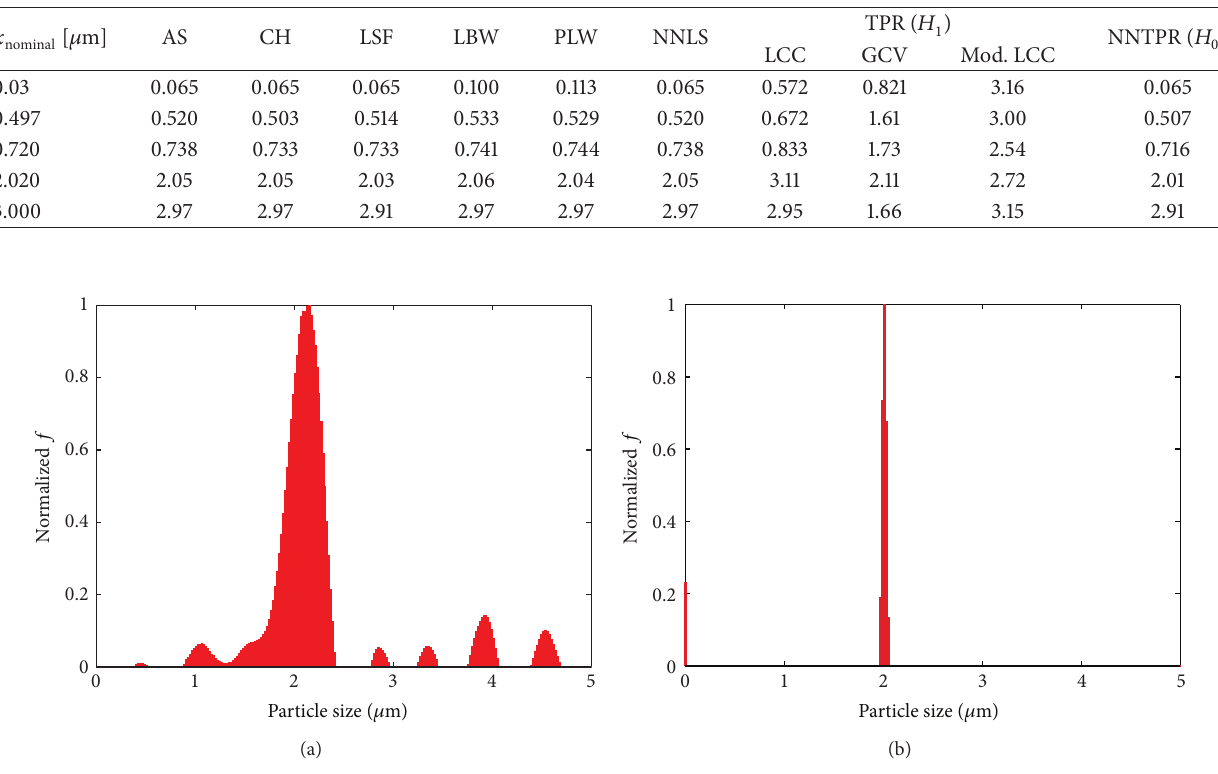
Table 6: Comparison of the retrieved Sauter mean particle size 𝑥 3,2 and 𝑙 = 250 .